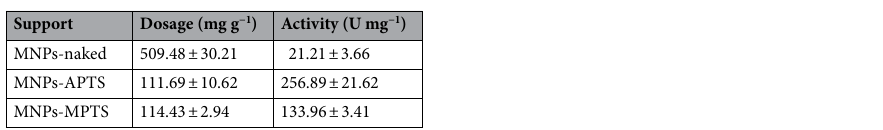
Table 1. Surface loading and catalytic activity values for the nanomagnetic supports evaluated.